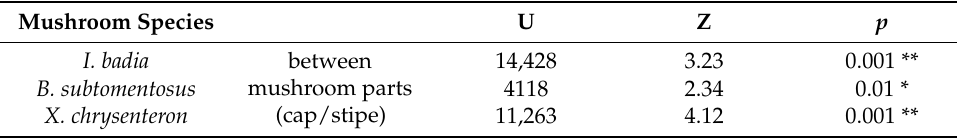
Figure 4. Bioaccumulation factor (BAF) values in caps and stipes and translocation quotient ( Qc/s ) values determined for three edible mushroom species (the data were logarithmized for better visual expression). Table 4. The results of the Mann-Whitney U test expressing differences in BAF values between caps and stipes within the species.